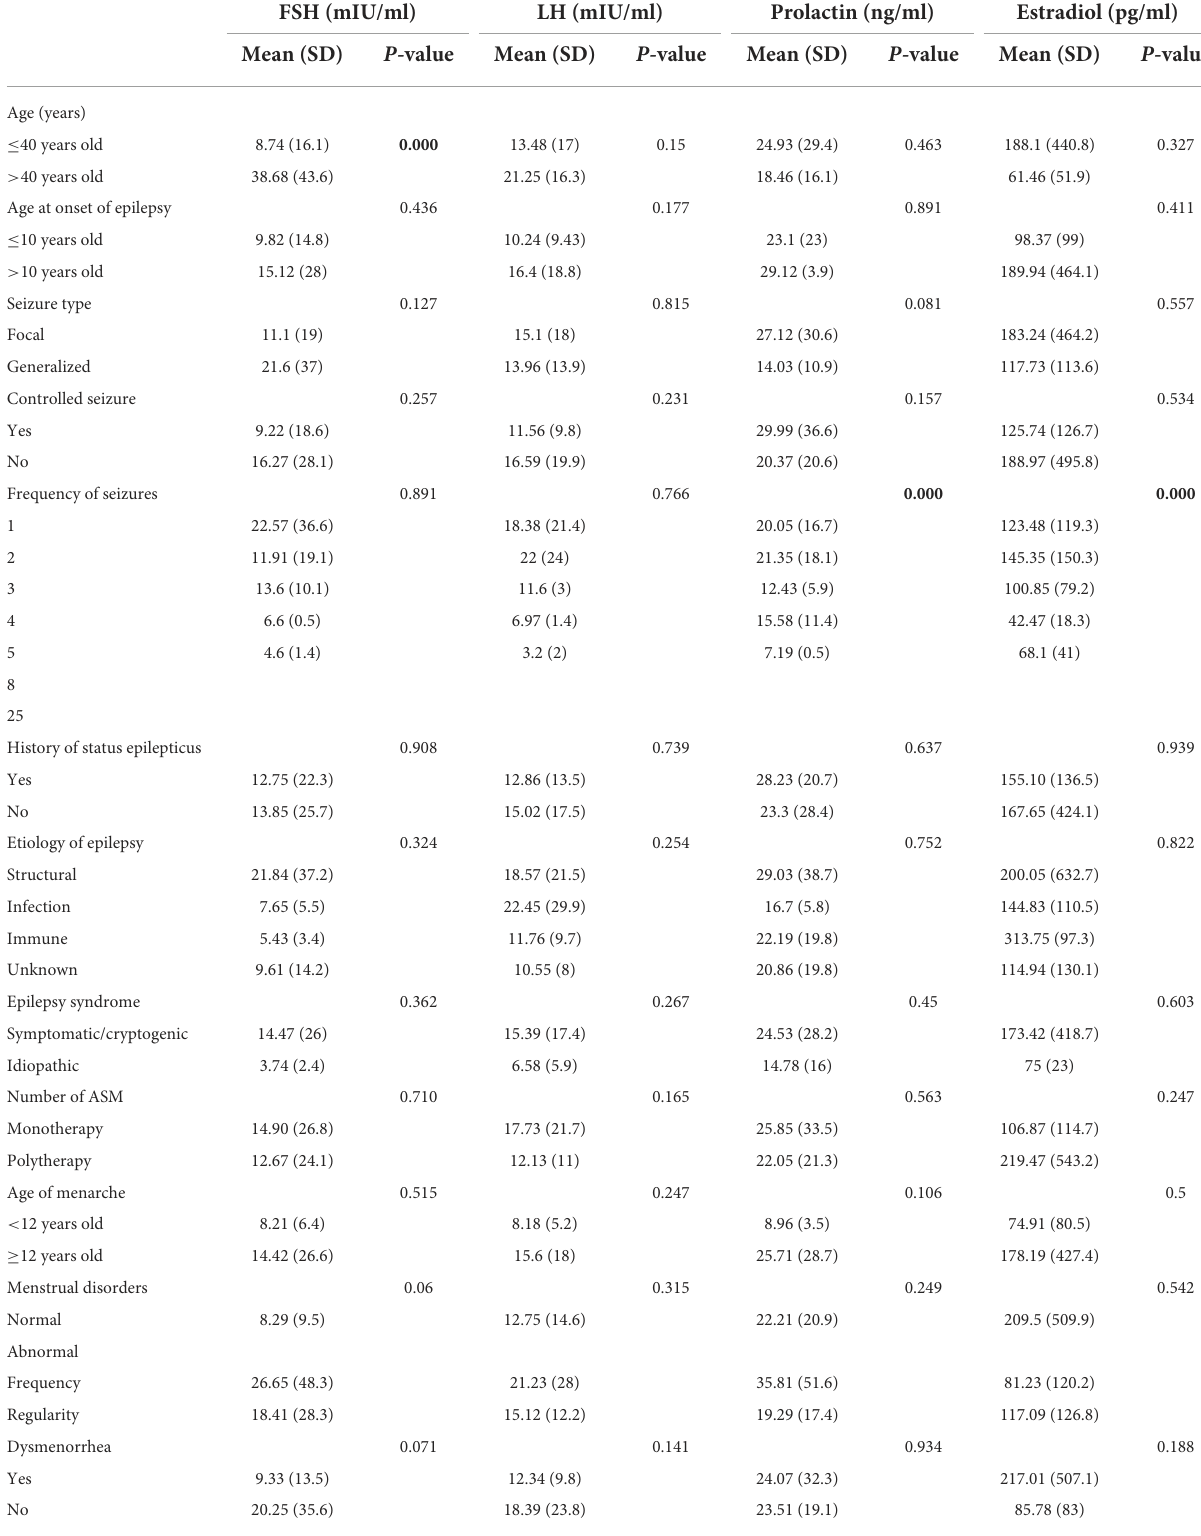
TABLE 4 The association of reproductive hormone with demographic and clinical factors in women with epilepsy.